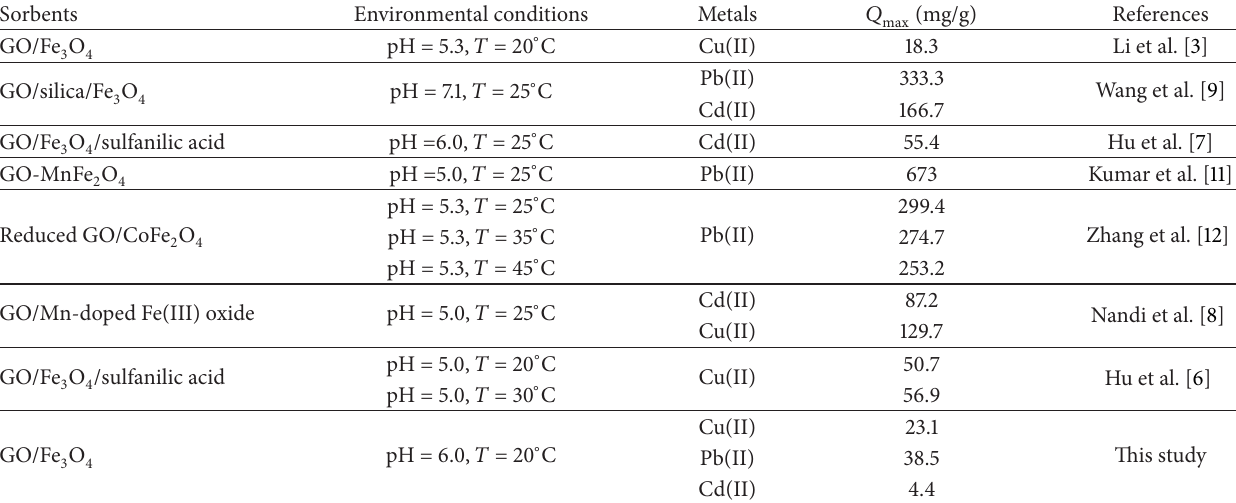
Table 2: Comparison of Cu(II), Pb(II), and Cd(II) adsorption capacities of this study with other recent reports using magnetic GO.